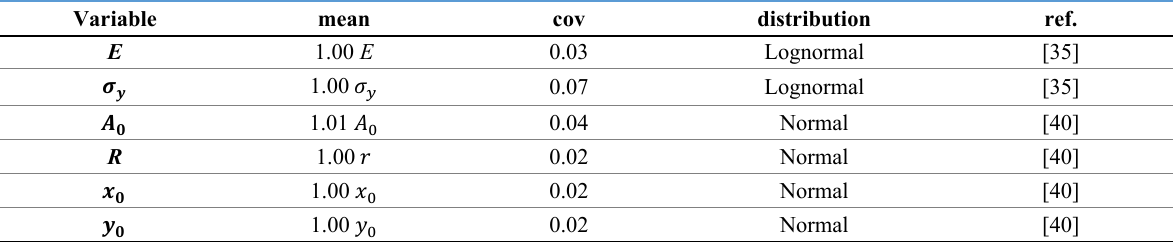
Table 5. Statistics for von Mises